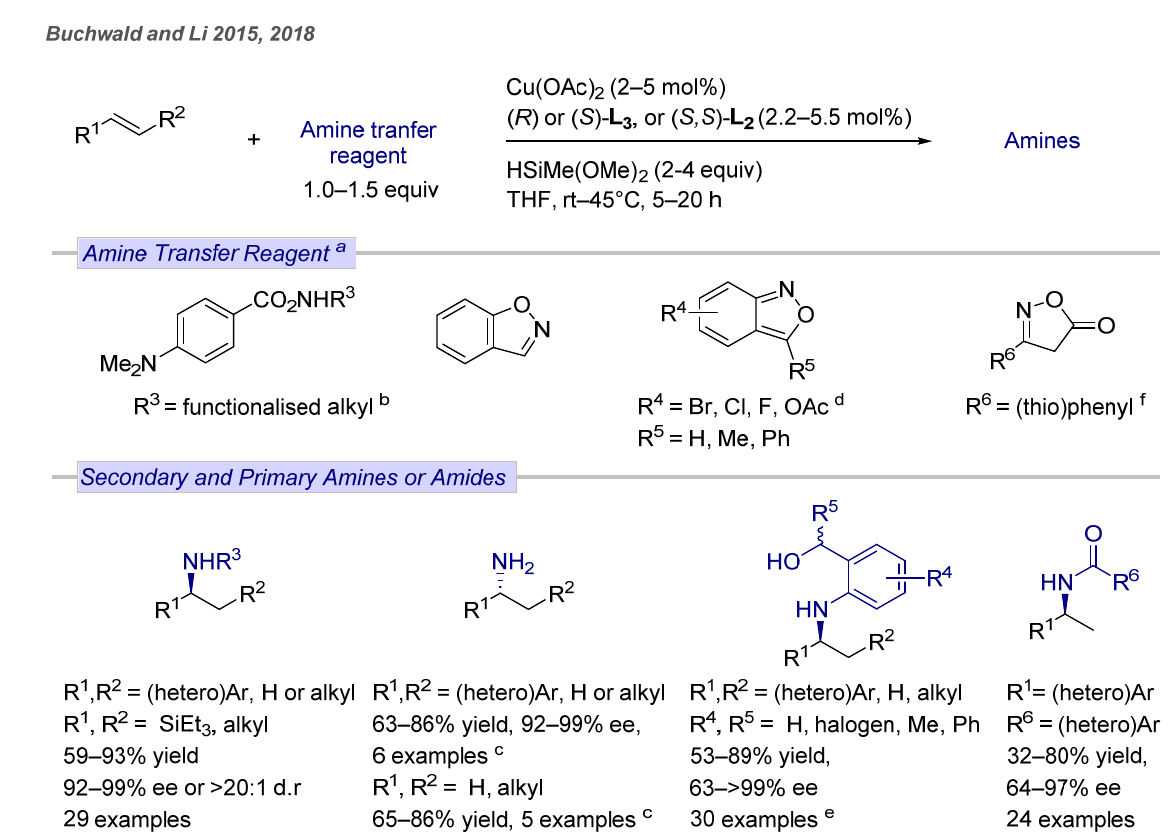
Figure 27. Regio- and enantioselective biphosphine·CuH-catalyzed hydroamination of alkene derivatives and electrophilic amines. ( a ) all reactions run with Cu(OAc) 2 , ( R )- or ( S )- L 3 , HSiMe(OMe) 2 in THF unless otherwise stated. ( b ) PPh 3 (4.4–8.8 mol%). ( c ) after work-up with NH 2 OH·HCl. ( d ) ( S , S )- L 2 (5.5 mol%), t -BuOH ( 2 equiv), cyclohexane. ( e ) after workup with NH 4 F. ( f ) ( S , S )- L 2 (4.4 mol%), Ph 2 SiH 2 (2 equiv), 1,4-dioxane/THF = 4:1. rt = room temperature, d.r = diasteromeric ratio, ee = enantiomeric excess.